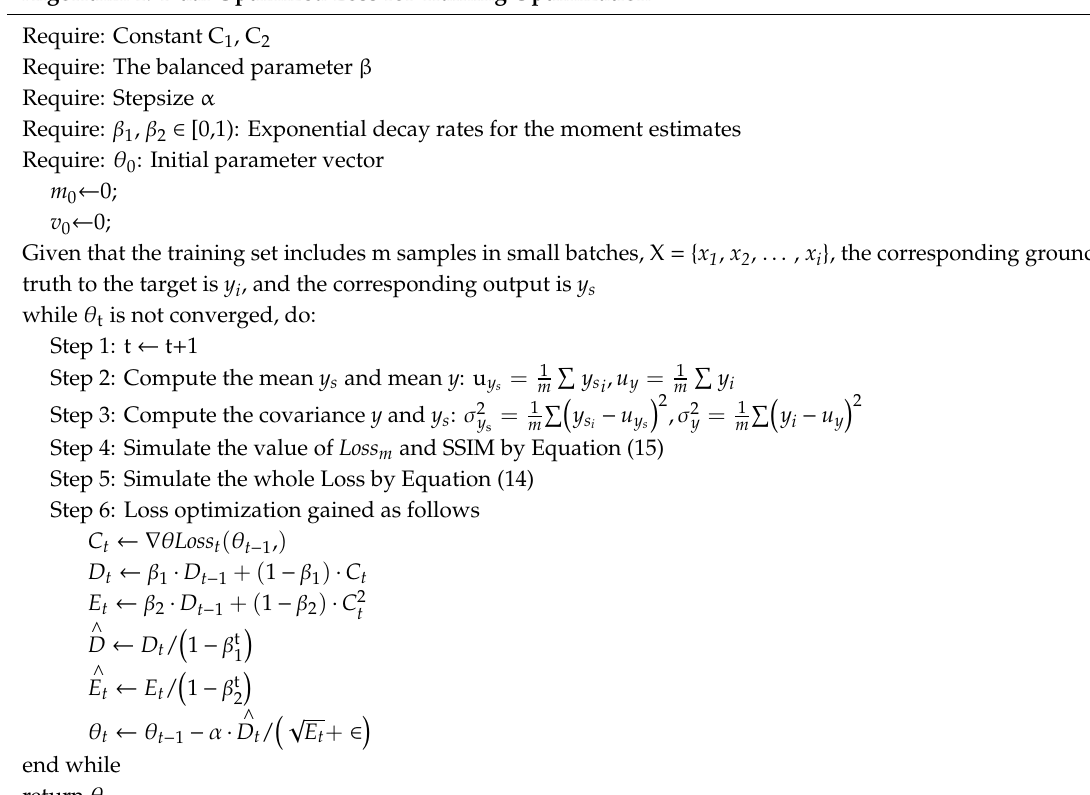
Algorithm 1: Dual Optimized Loss for Training